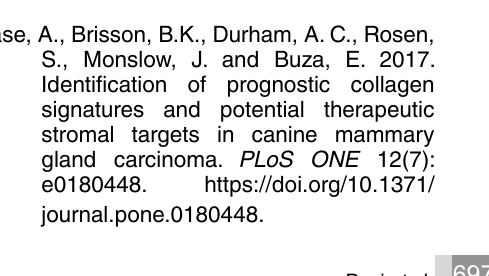
Fig.11. Stiff linearised and fully straightened collagen SEM 1.14kx SEM 10.0kx